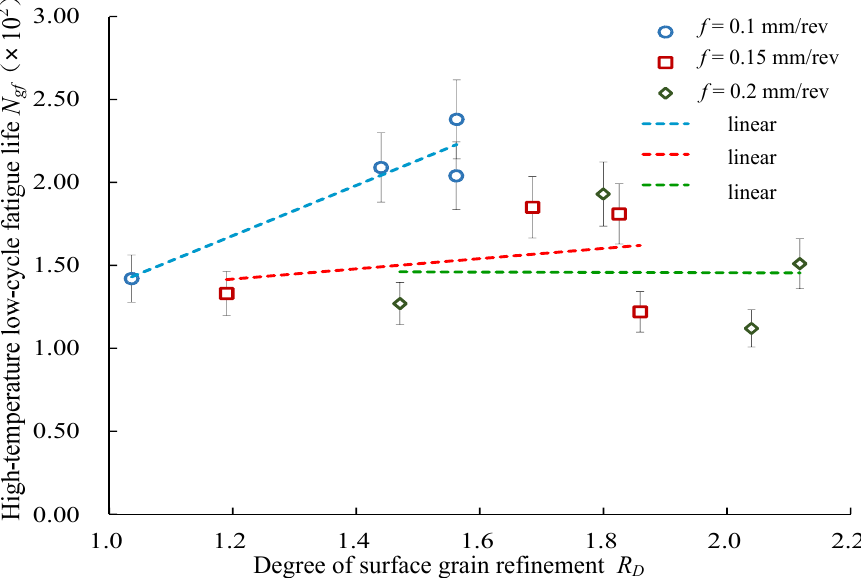
Figure 12. Effects of surface grain refinement on high-temperature low-cycle fatigue life.